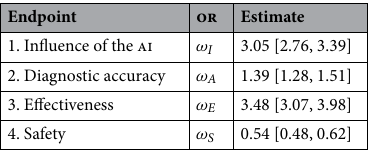
Table 2. Odds-ratios (or) for each of the main endpoints. We report in brackets the 95% confidence intervals for the odds